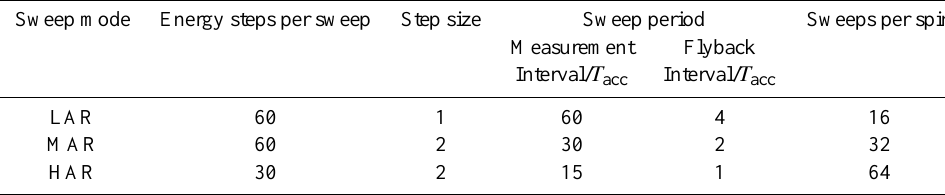
Table 3. PEACE electrostatic analyser HV sweep modes.